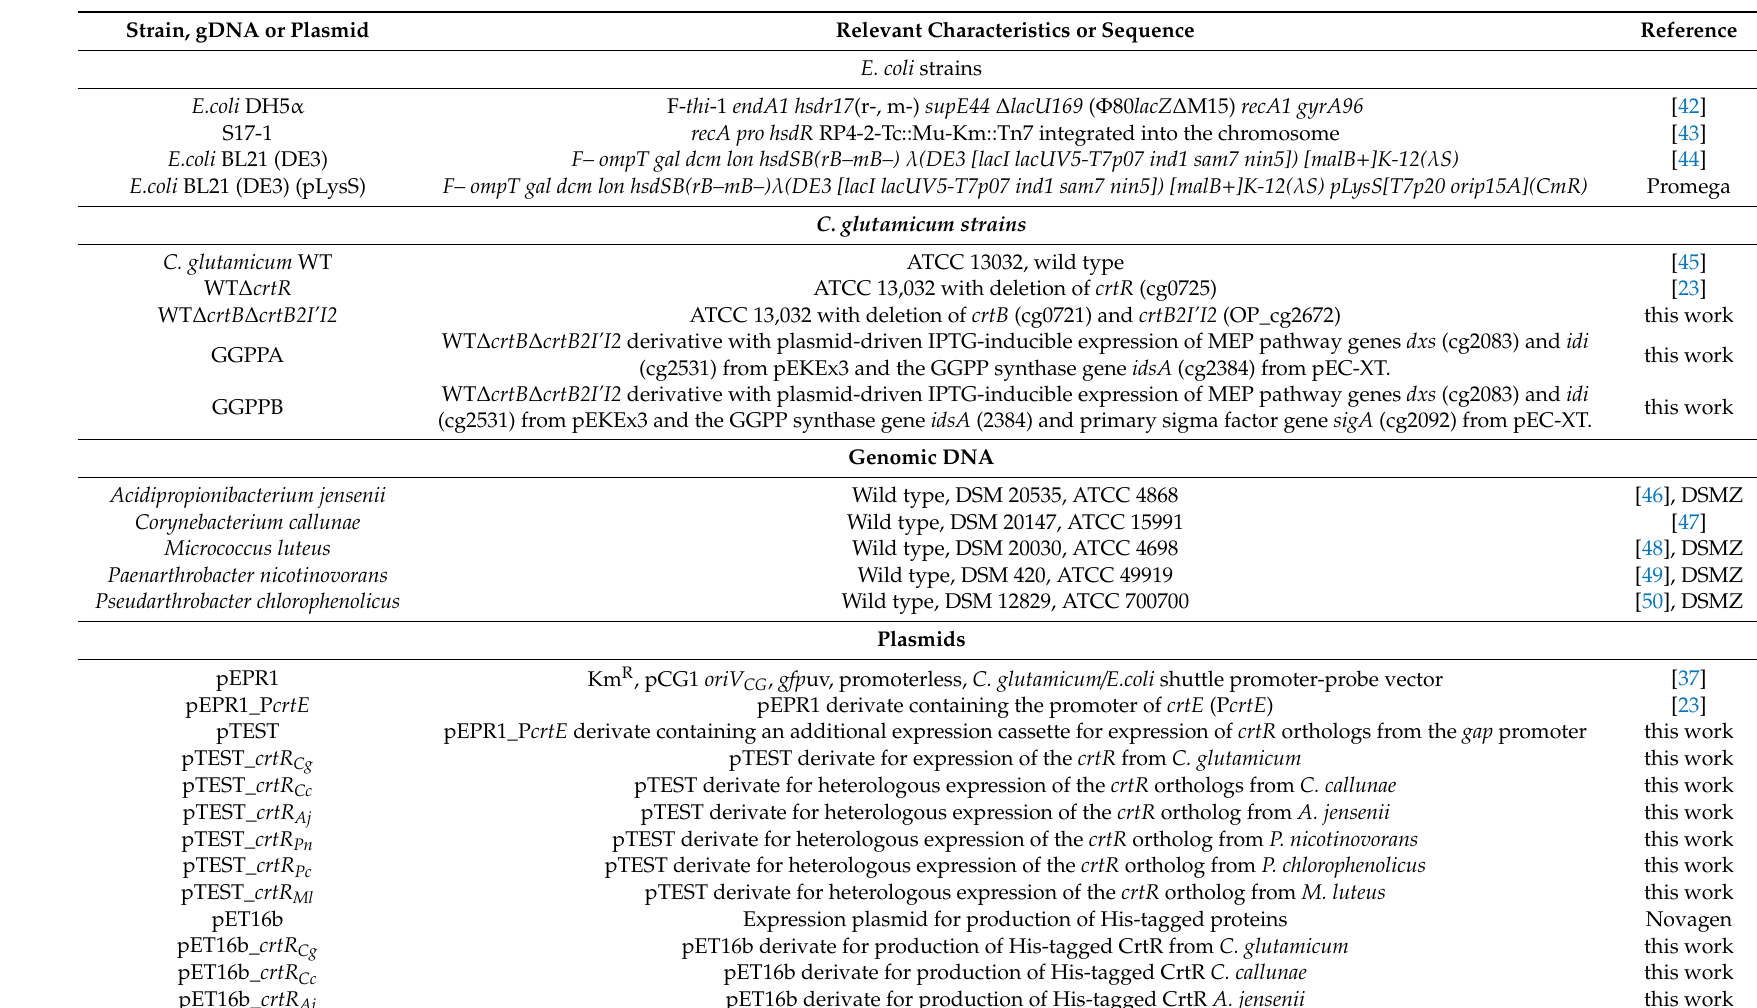
Table 1. Strains, genomic DNA and plasmids used in this